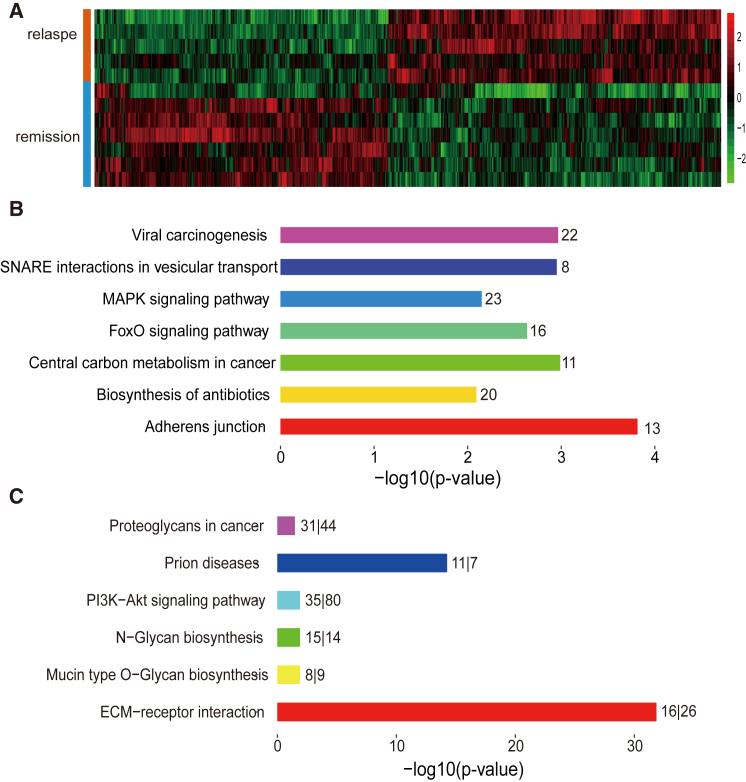
The Function Enrichment Analysis(A) The clustered heatmap of all DEGs in relapse and remission. Relatively higher expression is shown in red and lower expression is in green. (B) KEGG enrichment of DEGs by DAVID database (p value < 0.01). Number beside bar, counts enriched in KEGG pathway. (C) KEGG enrichment of DEMs by DIANA-miRPath (p value < 0.05). Number beside bar, targets of DEMs enriched in KEGG pathway; m/n, DEMs/targets.